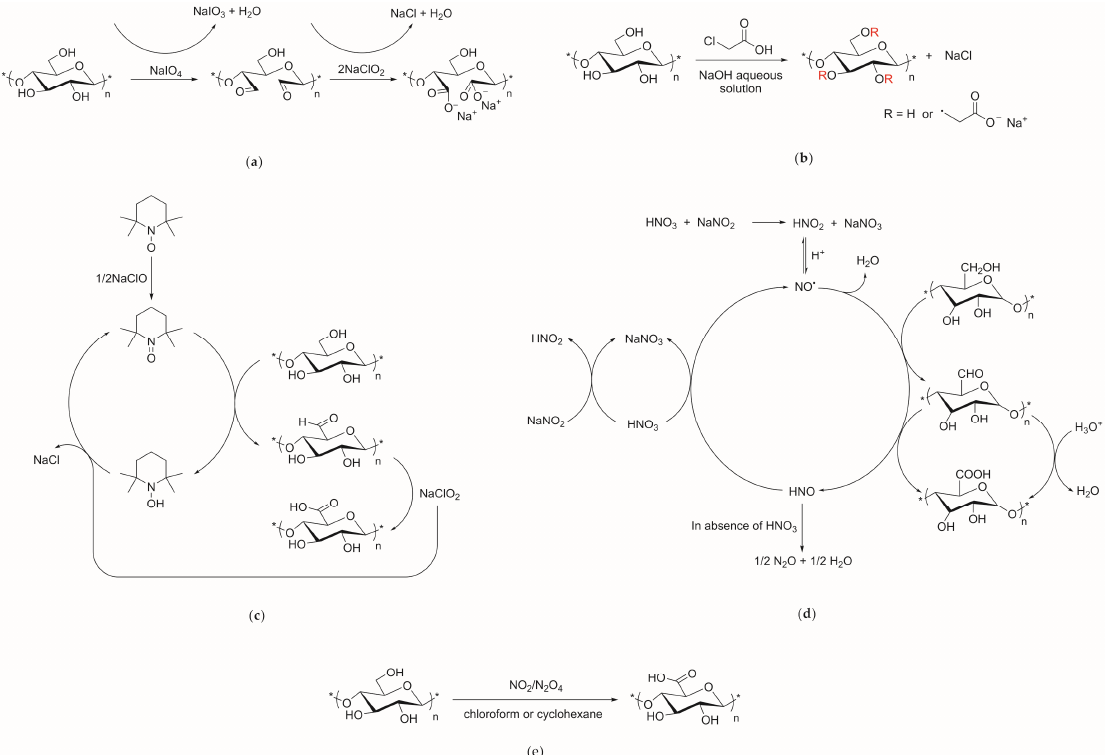
Figure 3. Mechanisms of cellulose carboxymethylation. ( a ) Two-step oxidation of periodate and sodium chlorite; ( b ) Carboxymethyl monochloroacetic acid; ( c ) TEMPO oxidation; ( d ) Nitric acid oxidation; ( e ) Oxidation of nitrous oxide/nitrogen dioxide system.